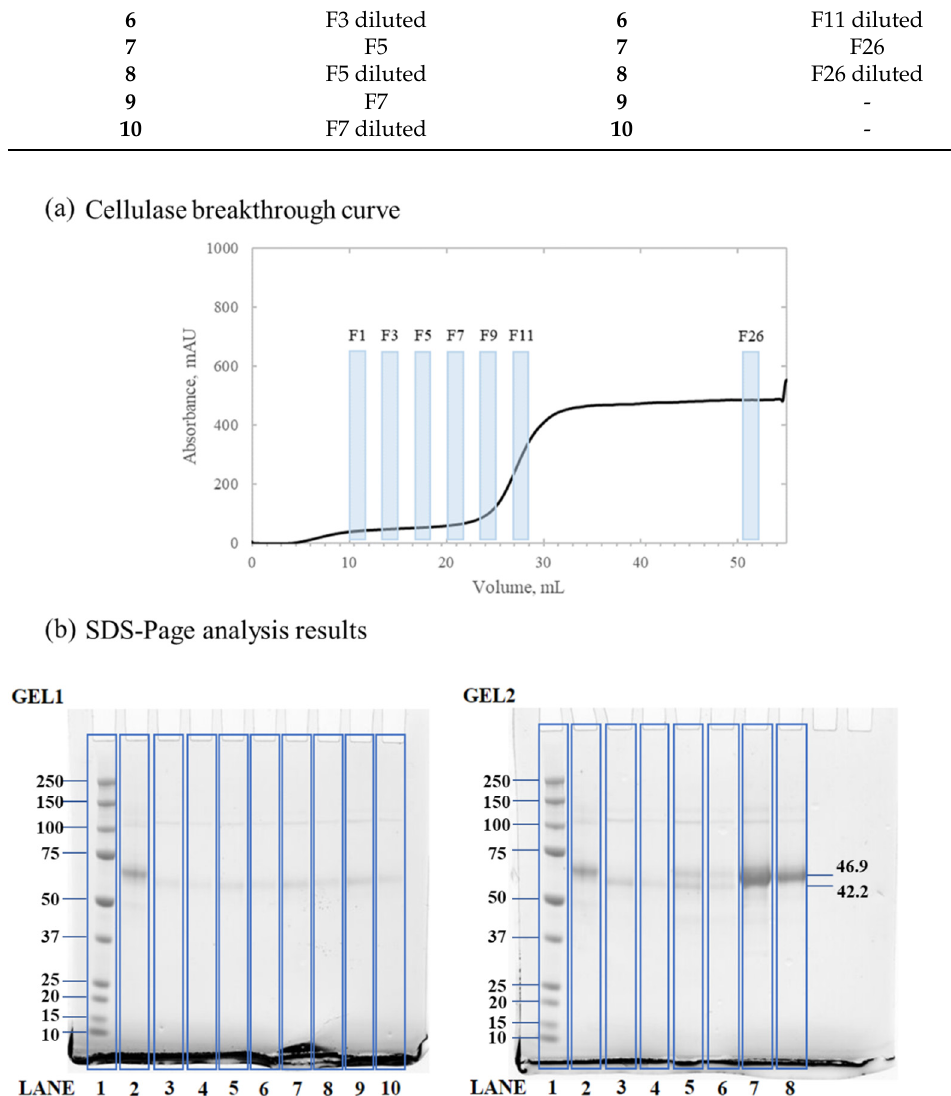
Figure 3. ( a ) Breakthrough curve performed with 2.5 mg/mL of Cellulase in 1 mol/L ammonium sulfate buffer. It is possible to notice two different plateaus in the curve, a lower one that occurs first and a higher one that occurs later; fractions analyzed with the SDS-Page are highlighted in light blue. ( b ) SDS-Page of the fractions collected for the Cellulase breakthrough run (see Table 2). Two SDS-Page were performed (Figure 3b) and, per each gel, the marker was loaded in the first lane, while the second lane contained the load of the breakthrough run, to have a comparison with the starting material loaded in the column. Samples coming from each fraction were loaded in the gel both as taken and diluted, since the concentration was not known a priori. The correspondence between fractions and lanes is reported in Table